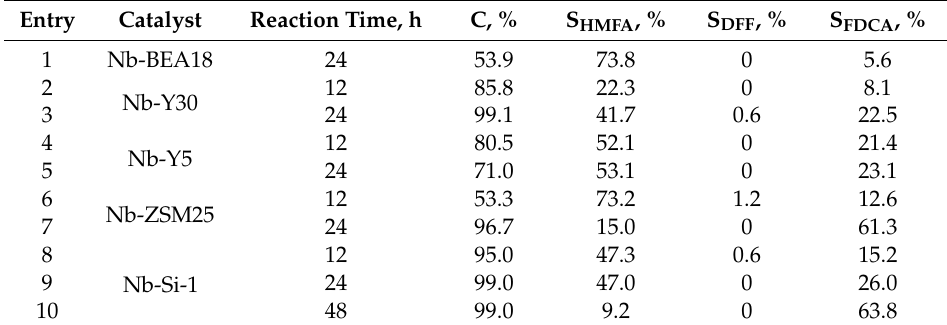
Table 5. The variation of the HMF conversion (C, %) and selectivities (S, %) to the main reaction products in the oxidation of HMF with t -butyl hydroperoxyde (t-BOOH) and in the presence of Nb-based zeolites